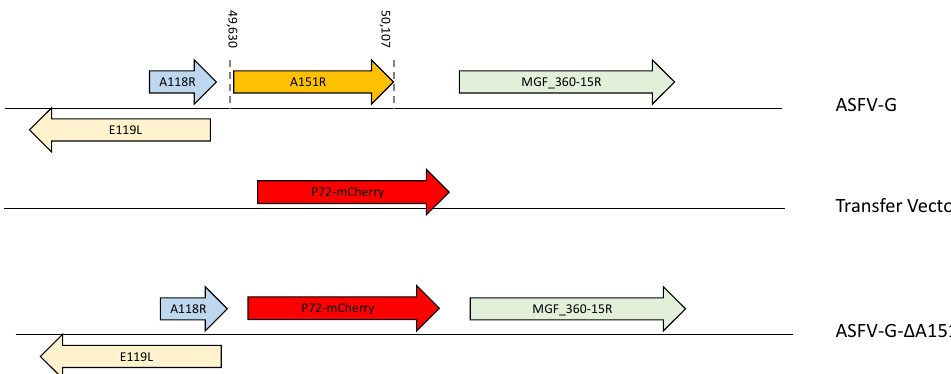
Figure 3. Schematic for the development of ASFV-G- ∆ A151R. The transfer vector contains the p72 promoter and a mCherry cassette; the flanking left and right arms are indicated and were designed to have flanking ends at both sides of the deletion/insertion cassette. The nucleotide positions of the ASFV-G genome are indicated. The resulting ASFV-G- ∆ A151R virus with the cassette inserted is shown on the bottom.